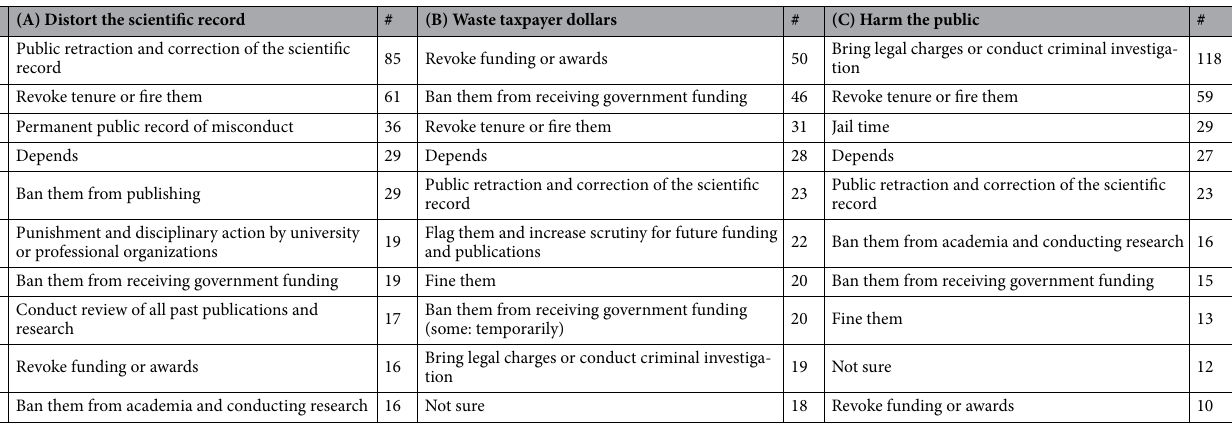
Table 5. What should happen to researchers found guilty of scientific misconduct that (a) distort the scientific record, (b) waste taxpayer dollars, or (c) harm the public? Top 10 responses, ranked in decreasing order by